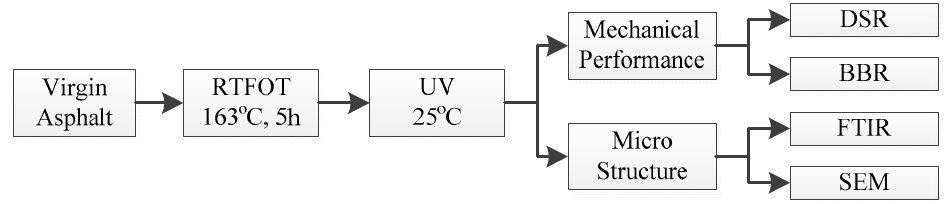
Figure 1. The flowchart of experimental design.